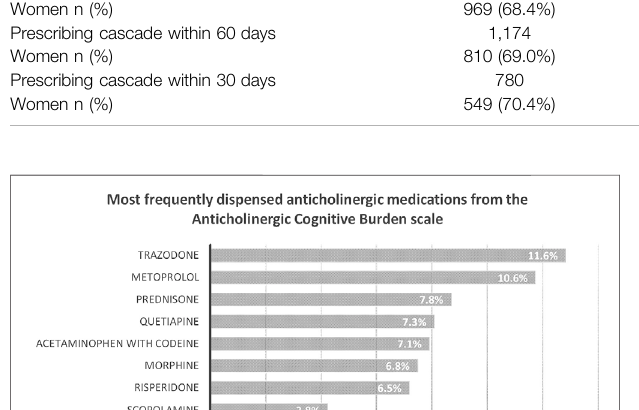
Table 1 . The most frequently dispensed anticholinergic